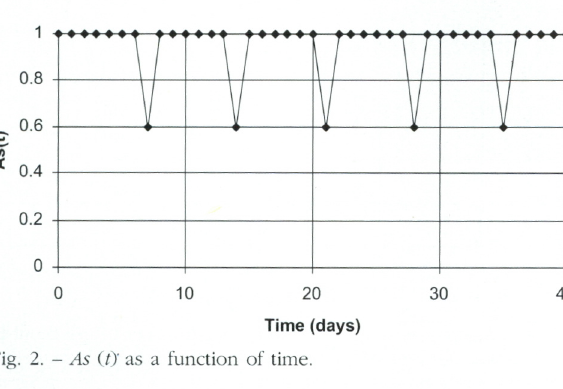
Fig. 2. - As ( t ) as a function of